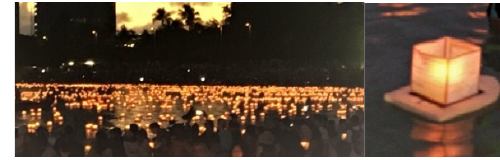
Figure 1. Lantern Floating Hawaii 1